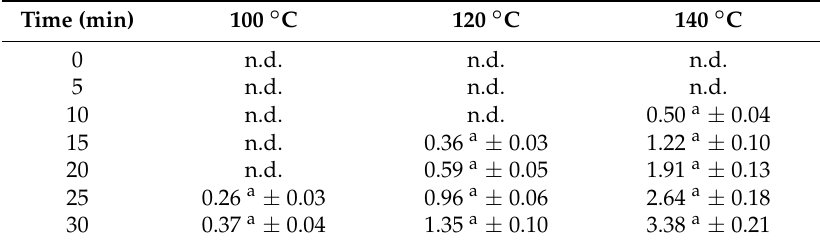
Table 4. Glucosylisomaltol content (mg · L − 1 ) in the model system glutamine-dextrinomaltose. Values are means ± SD, n = 3; Different letters within a column indicate significant differences between groups ( p < 0.05); n.d. = not detected.